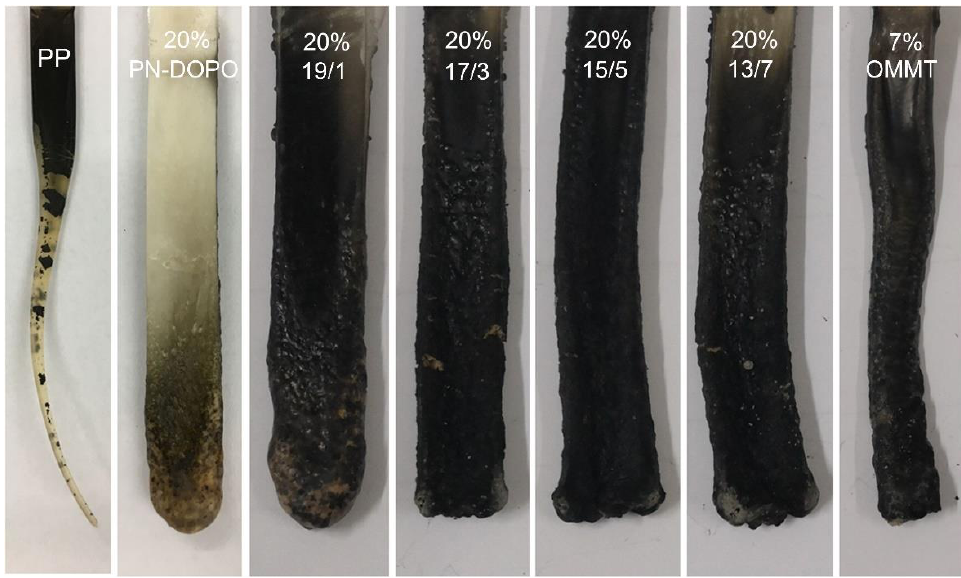
Figure 1. Images of PP and flame-retarded PP composites after UL-94 tests.